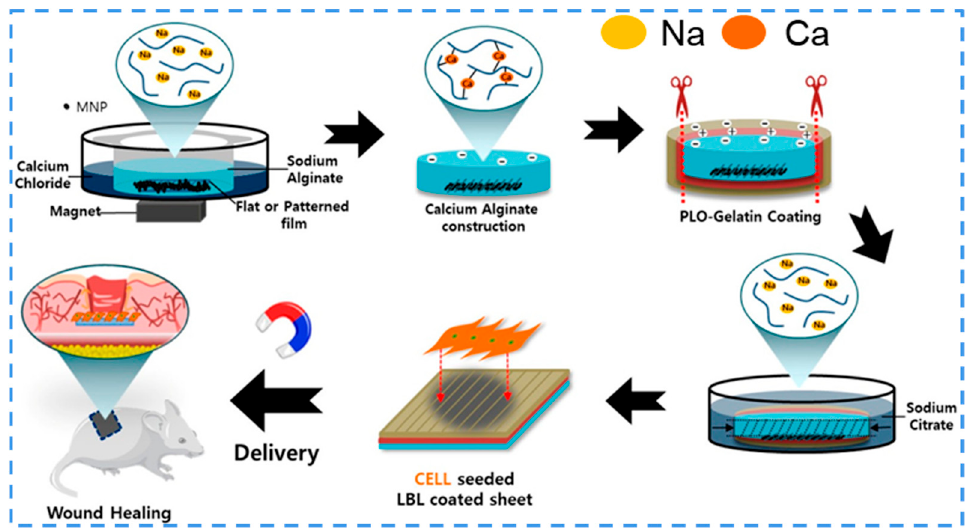
Figure 10. Schematic of the synthesis procedure of MNPs-embedded hydrogel sheet with groove pattern for wound healing. Reproduced with permission [191]. Copyright 2019, The American Chemical Society.